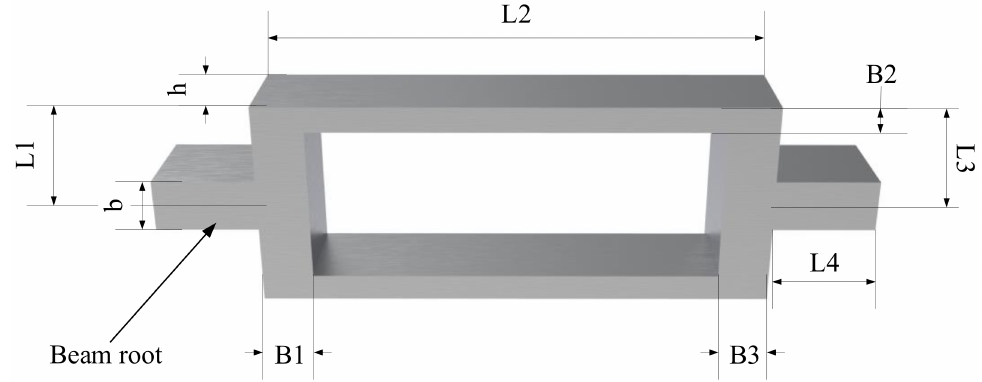
Figure 11. Resonator structure diagram.